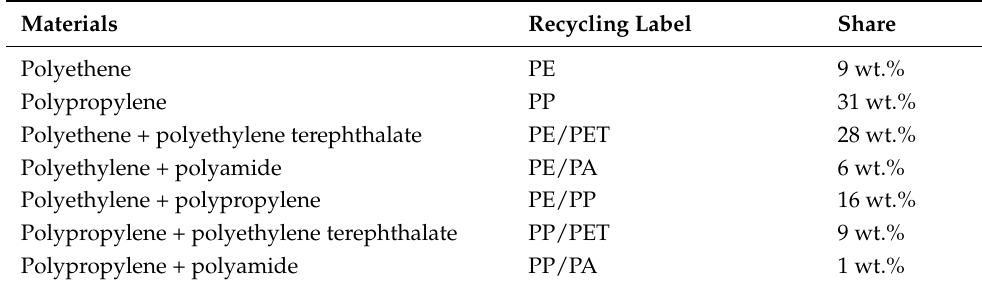
Table 1. List of mono- and multilayer materials used in the sorting